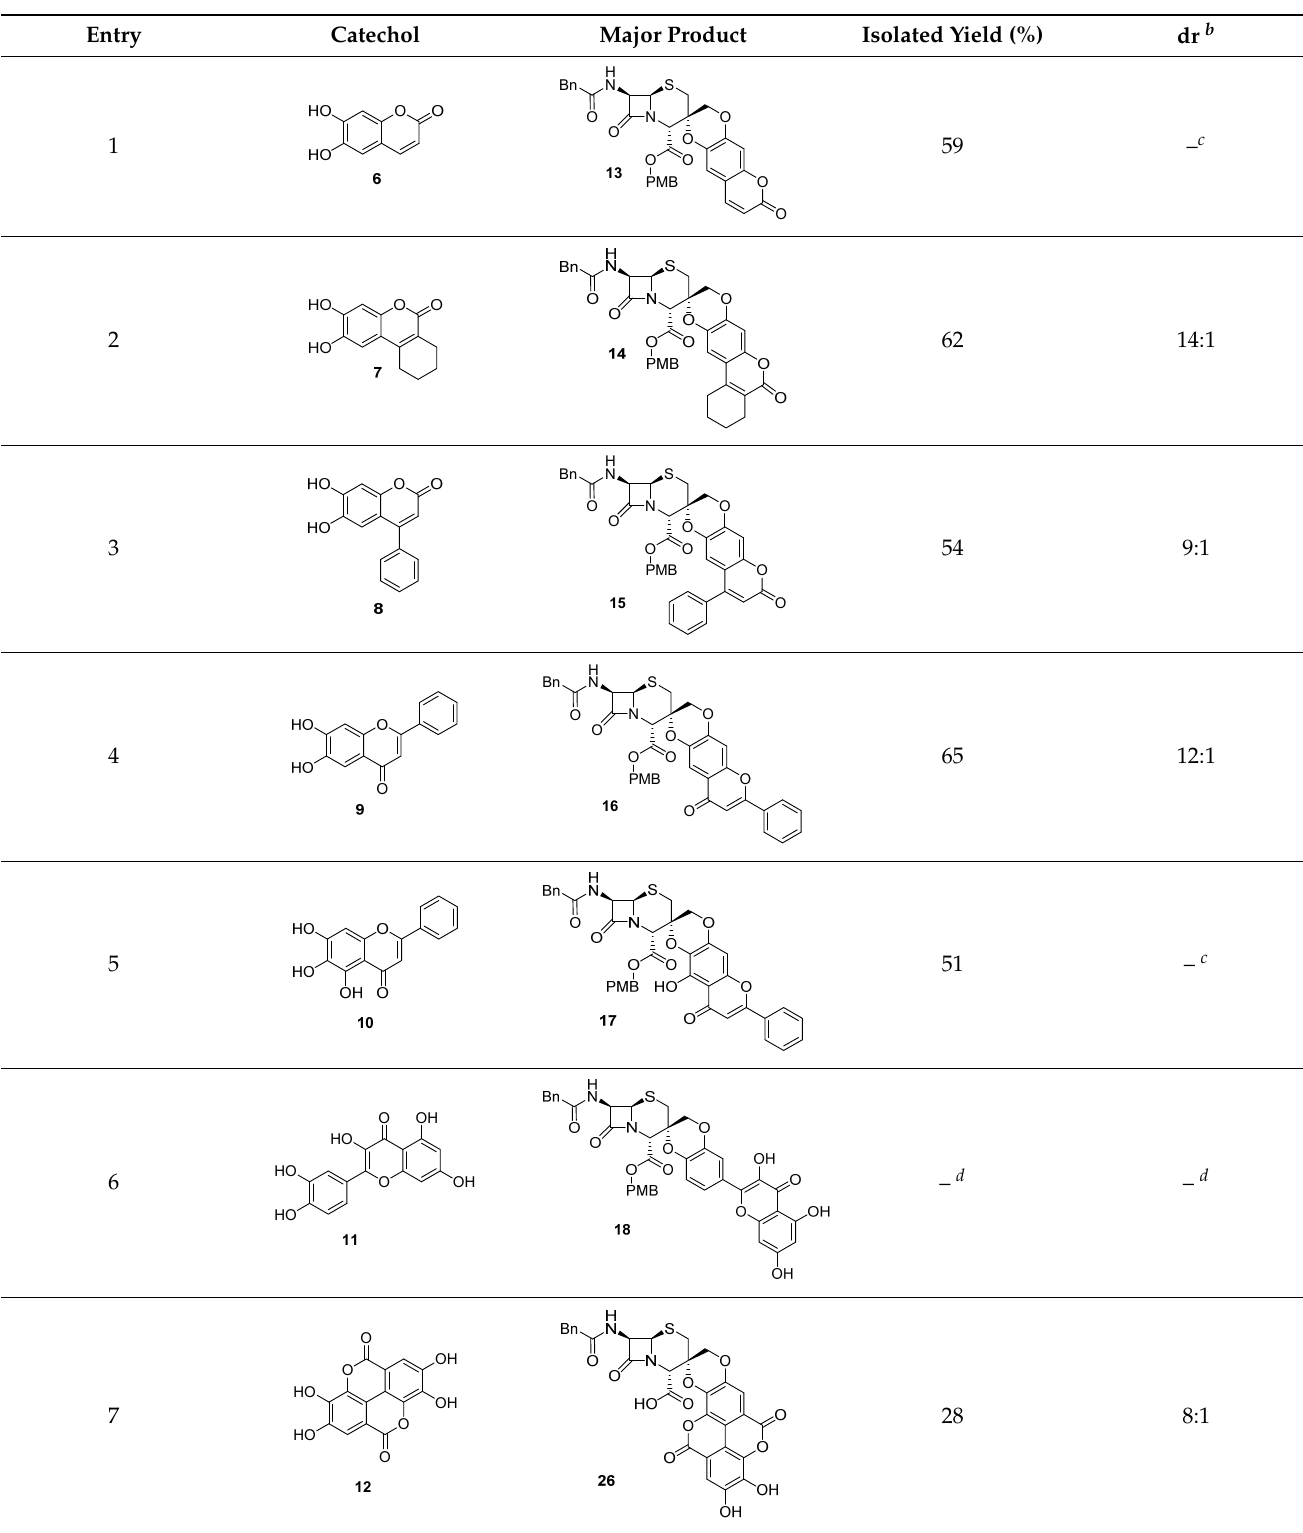
Table 1. Reaction scope for the synthesis of spiro-cephalosporins a .